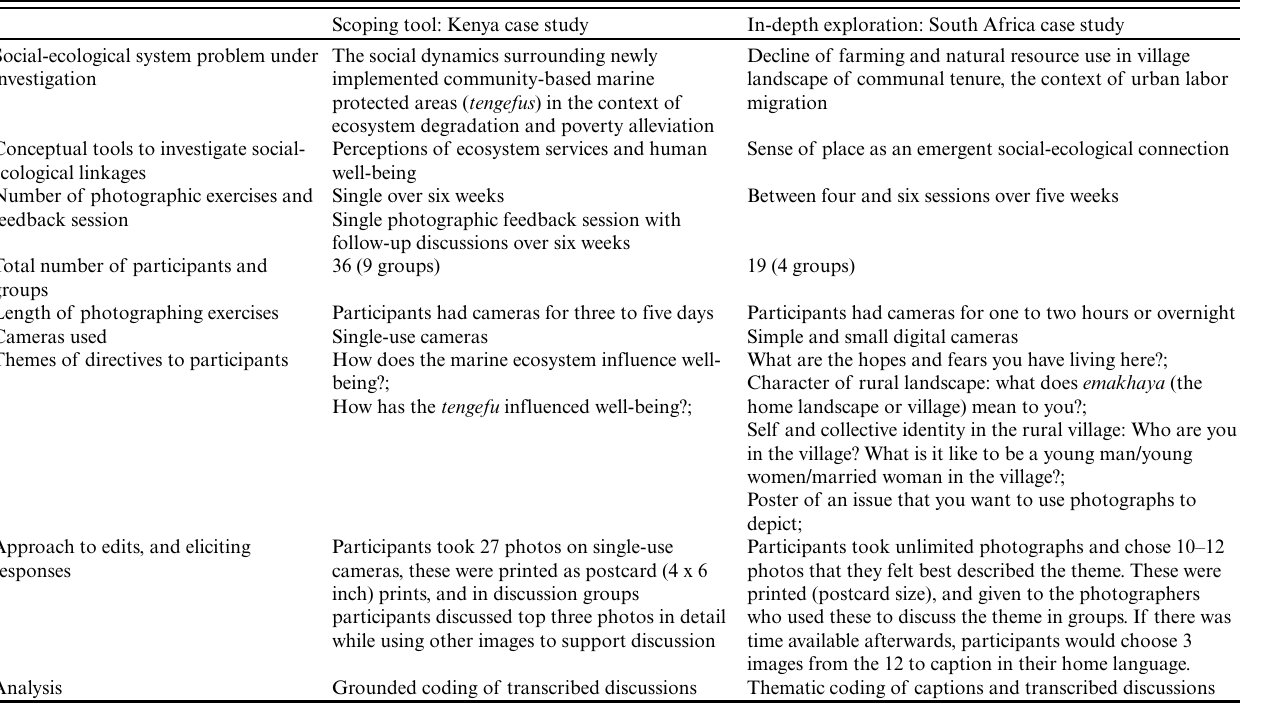
Table 1 . Comparison of application of photovoice method in two case studies. More information can be found in Mahajan and Daw (2016), Masterson (2016), and Masterson et al.